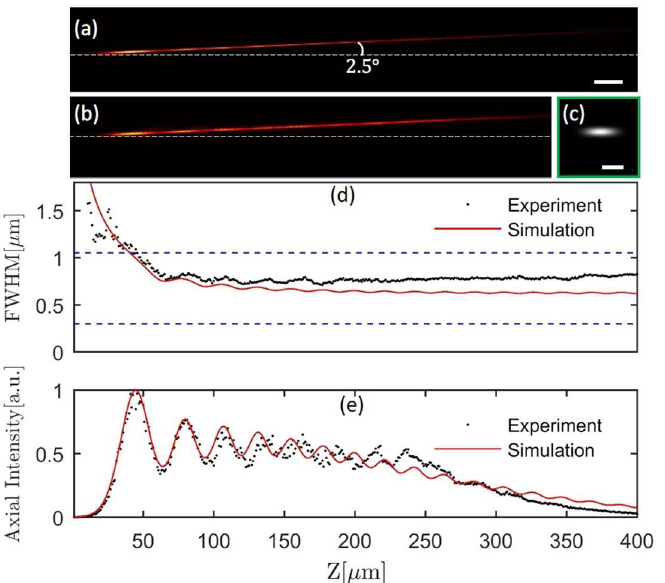
Fig 4. Simulated and measuredtwo-photon excitation PSF2p of Bessel beams with small tilted angle ( (cid:25) 2.5˚). (a) Numerical simulation. Scale bar 20 μ m. (b) MeasuredPSF2p. (c) PSF2p with